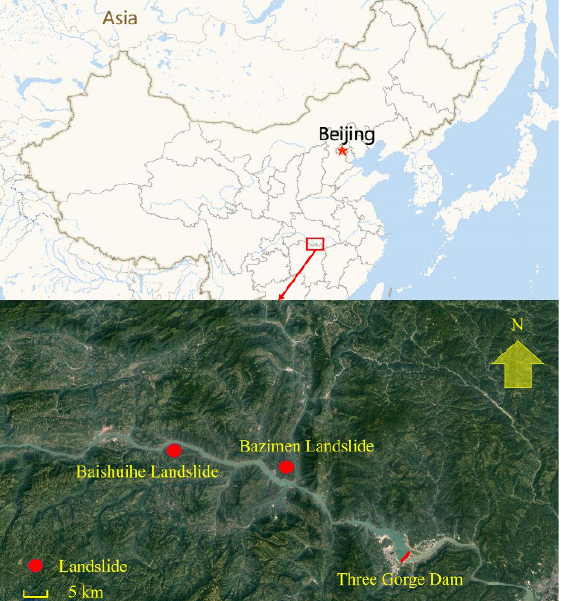
Figure 4. Geographical locations of the Baishuihe and Bazimen landslides.